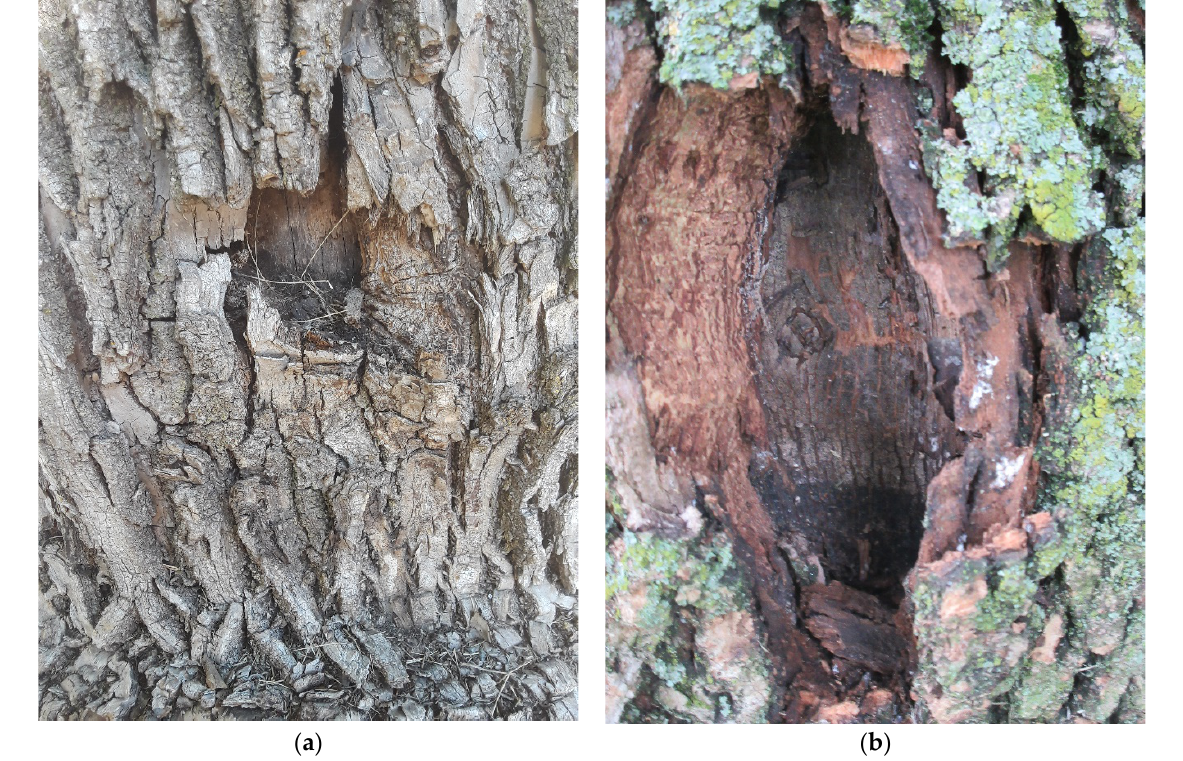
Figure A4. ( a ) Example appearance of wound with wound wood development; ( b ) Example wound with sunken appearance and wound wood development.